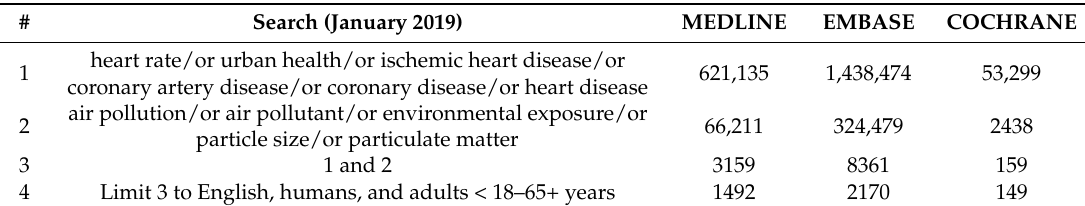
Table 1. Results of the literature search regarding air pollution and health effects in persons living with coronary artery disease.